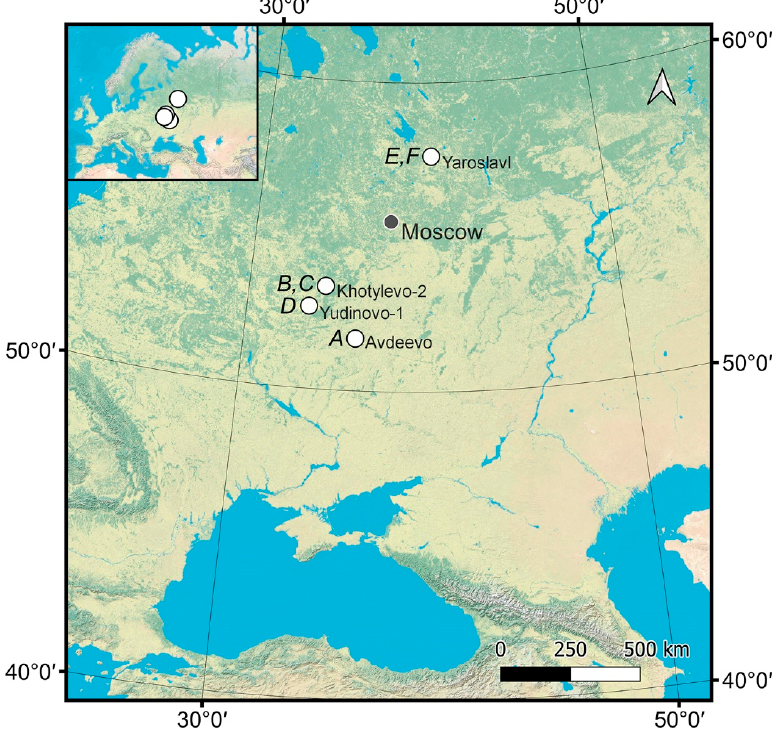
Figure 1. Locations of the study sites on the East European Plain. Indices are explained in Section 2.1 below and Table 1. Table 1. Brief characteristics of the study sites and anthropogenically transformed soil horizons—cultural layers (CLs) and plough layers